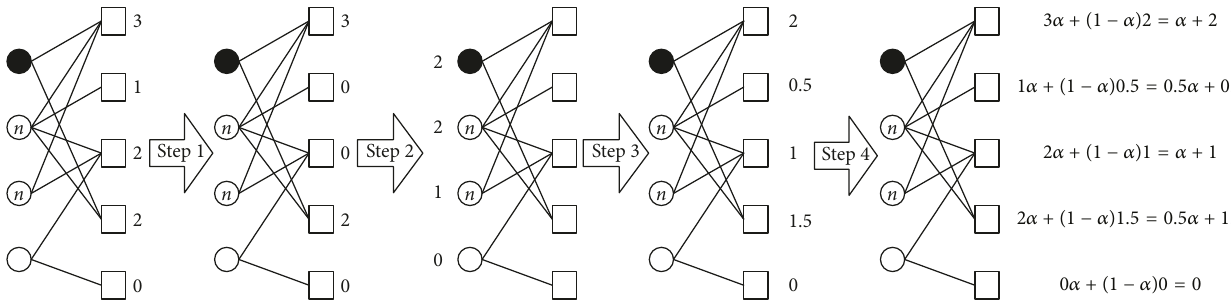
Figure 2: A novel preferential diffusion algorithm by user’s nearest neighbors at work on the bipartite user-object network. Users are shown as circles and objects are squares. The target user is indicated by the black circle and the nearest neighbors of the target user are the circles which have a letter “ 𝑛 ” in them and 𝛼 is the variable parameter.